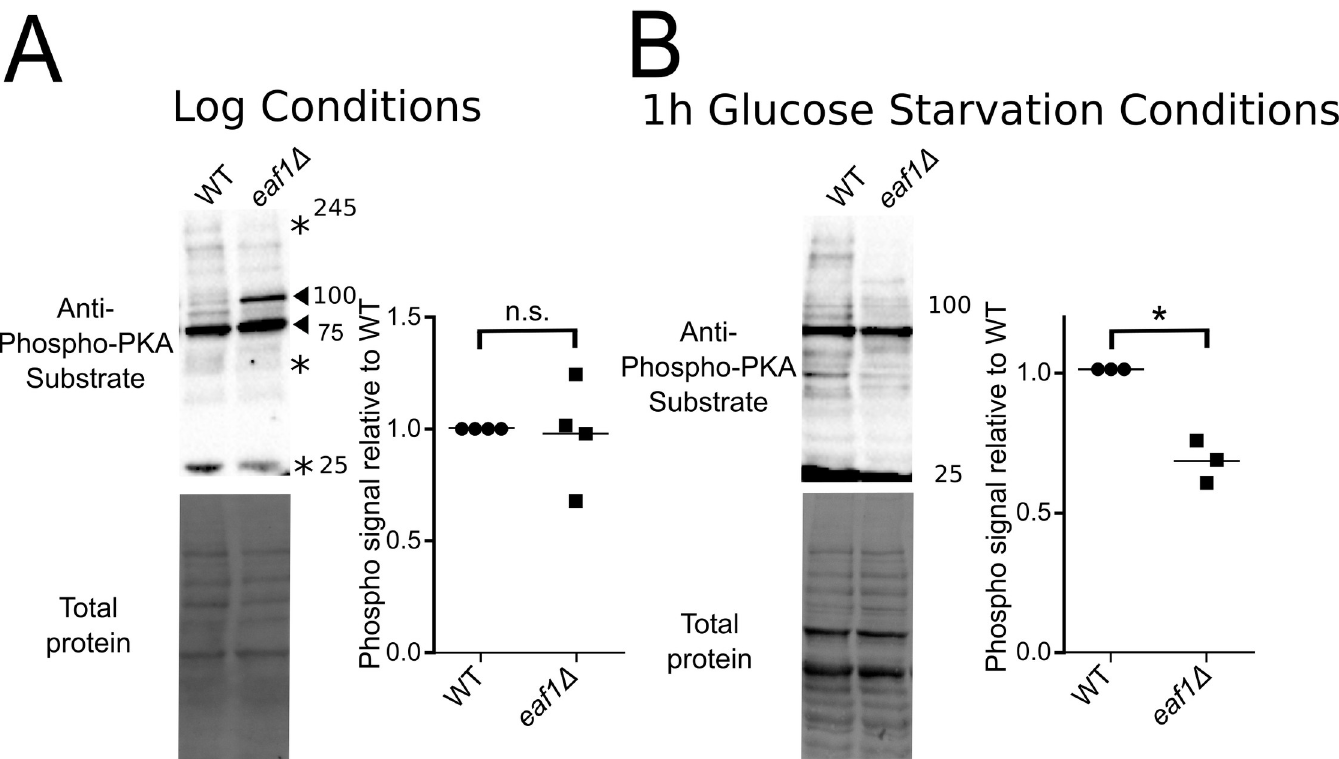
Fig 9. PKA activity is altered in an eaf1 Δ . (A) PKA substrate phosphorylation under glucose rich conditions was assessed by quantitative western blot analysis using whole cell extracts from WT and eaf1 Δ strains. Panel to the left is a representative of a total phosphorylation and a total protein blot (Stars highlight bands that decreased and arrows highlight bands that increase in eaf1 Δ extracts); panel to the right is the quantification of western blots for four independent biological replicates where the total phosphorylation signal intensity was normalized to total protein. (B) PKA substrate phosphorylation under glucose starvation conditions was assessed by quantitative western blot analysis using whole cell extracts from WT and eaf1 Δ strains that were starved for glucose for 1 hour. Panel to the left is a representative total phosphorylation and total protein blot; panel to the right is the quantification of western blots for three independent biological replicates where the total phosphorylation signal intensity was normalized to total